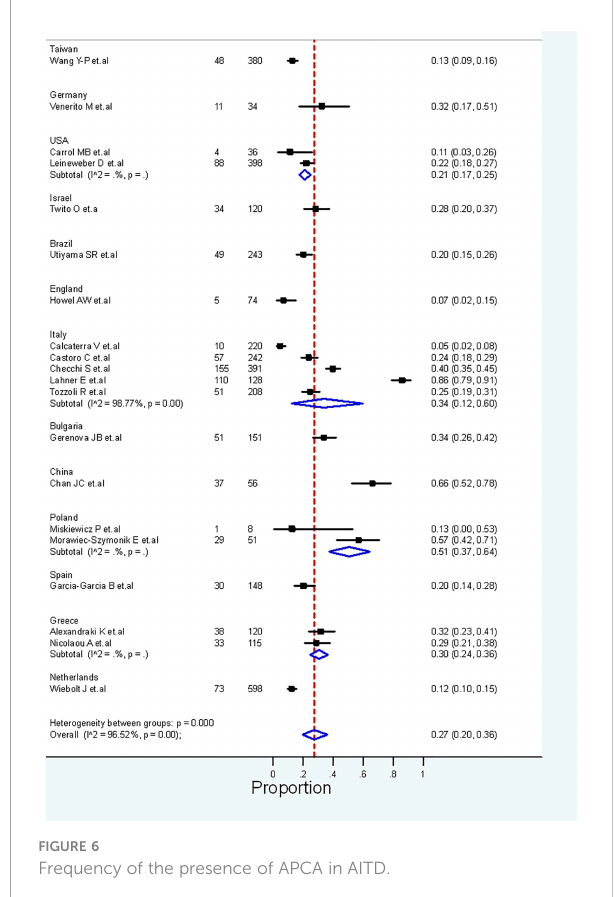
FIGURE 6 Frequency of the presence of APCA in